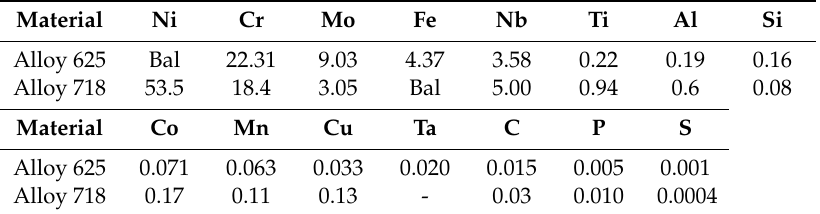
Table 1. Chemical composition (wt %) for alloy 625 and alloy